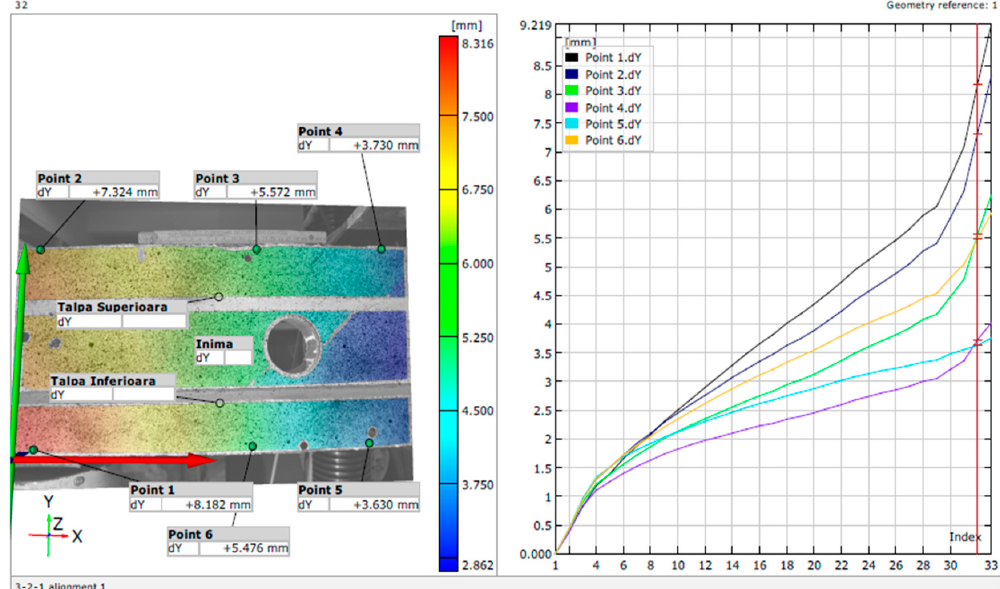
Figure 6. Vertical displacements of the fly ash beam (GR-3-CZ) analyzed with GOM Correlate.